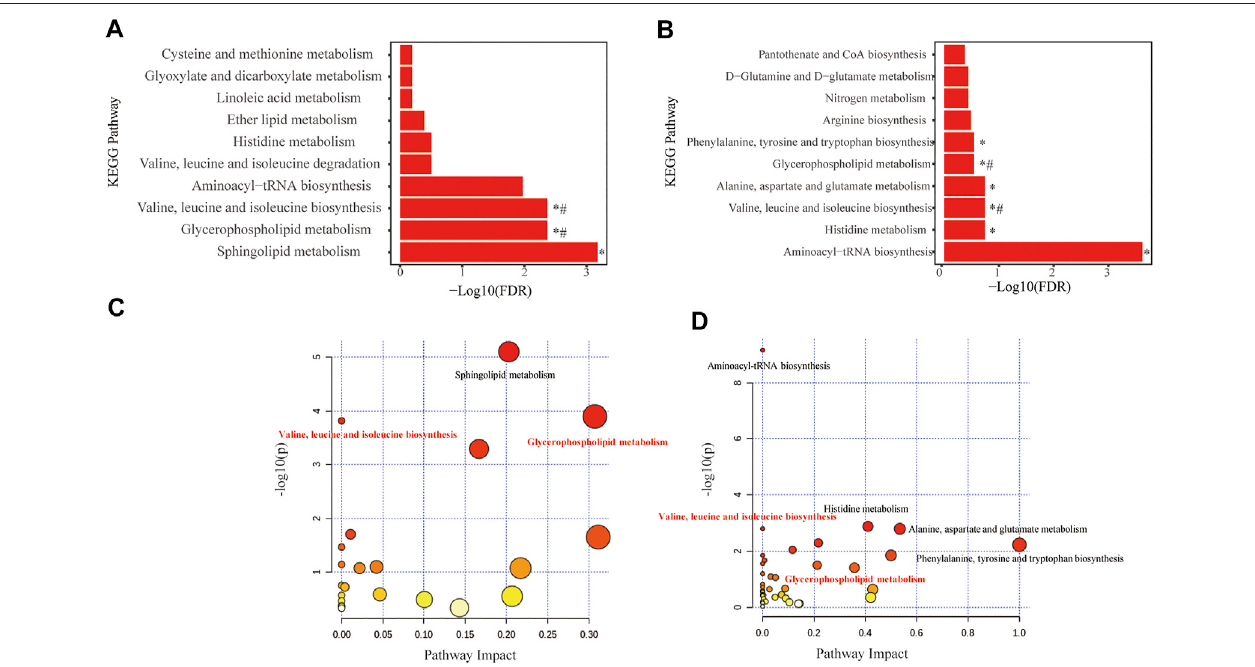
FIGURE4| Metabolomeviewofpathway impact analysisobtained from differential metabolites inCOPD.Signi fi cantlyaltered pathways indiscovery set (A,B) and inreplicationset (C,D) .Thecolorandsizeofeachcirclearebasedon p -values(yellow:higher p -valuesandred:lower p -values)andpathwayimpactvalues(thelargerthe circle, the higher the impact score) calculated from the topological analysis, respectively. Pathways were considered signi fi cantly changed if adjusted p -value (FDR) < 0.05. *Signi fi cantly changed pathways in the recovery or replication set. #Signi fi cantly changed pathways in both the recovery and replication sets. FDR, False discovery rate.